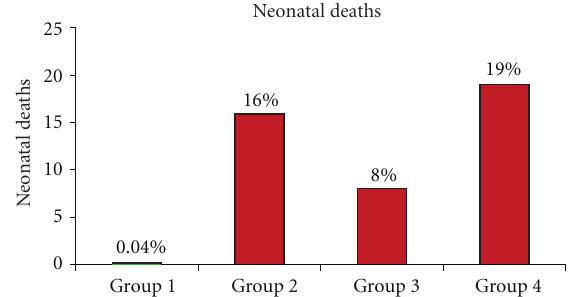
Figure 4: The percentages of neonatal deaths in the control group and in the three groups exposed to elevated